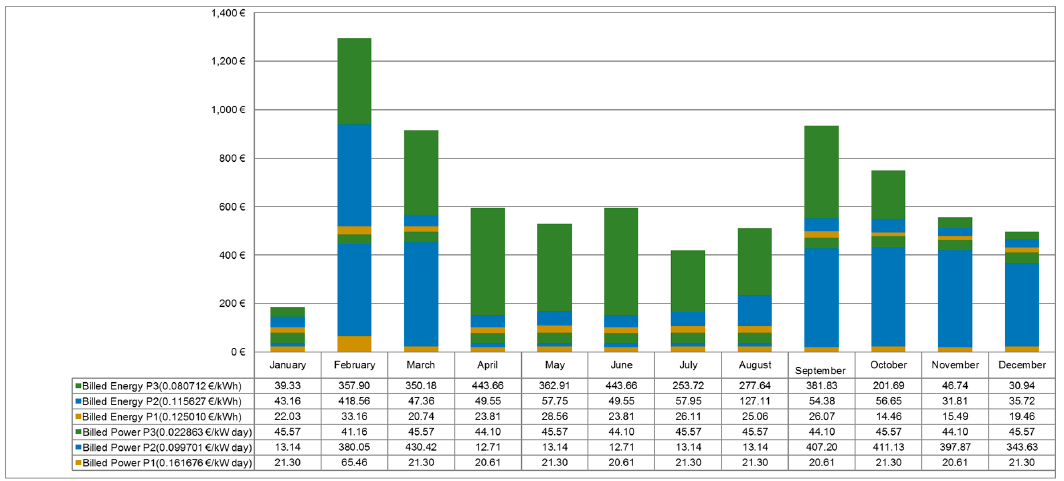
Figure 6. WWTP financial expense. 2016.